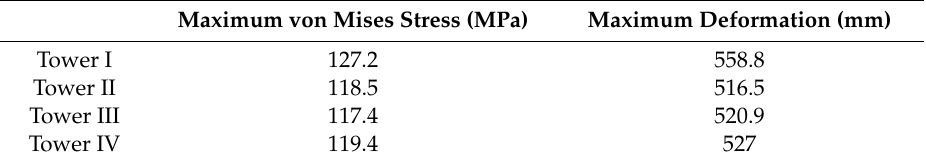
Figure 24. Deformation contours of towers III and IV in a marine environment. ( a ) Tower III, ( b ) Tower IV, (in mm). Table 2. Maximum von Mises stresses and deformations of towers I, II and III, IV.